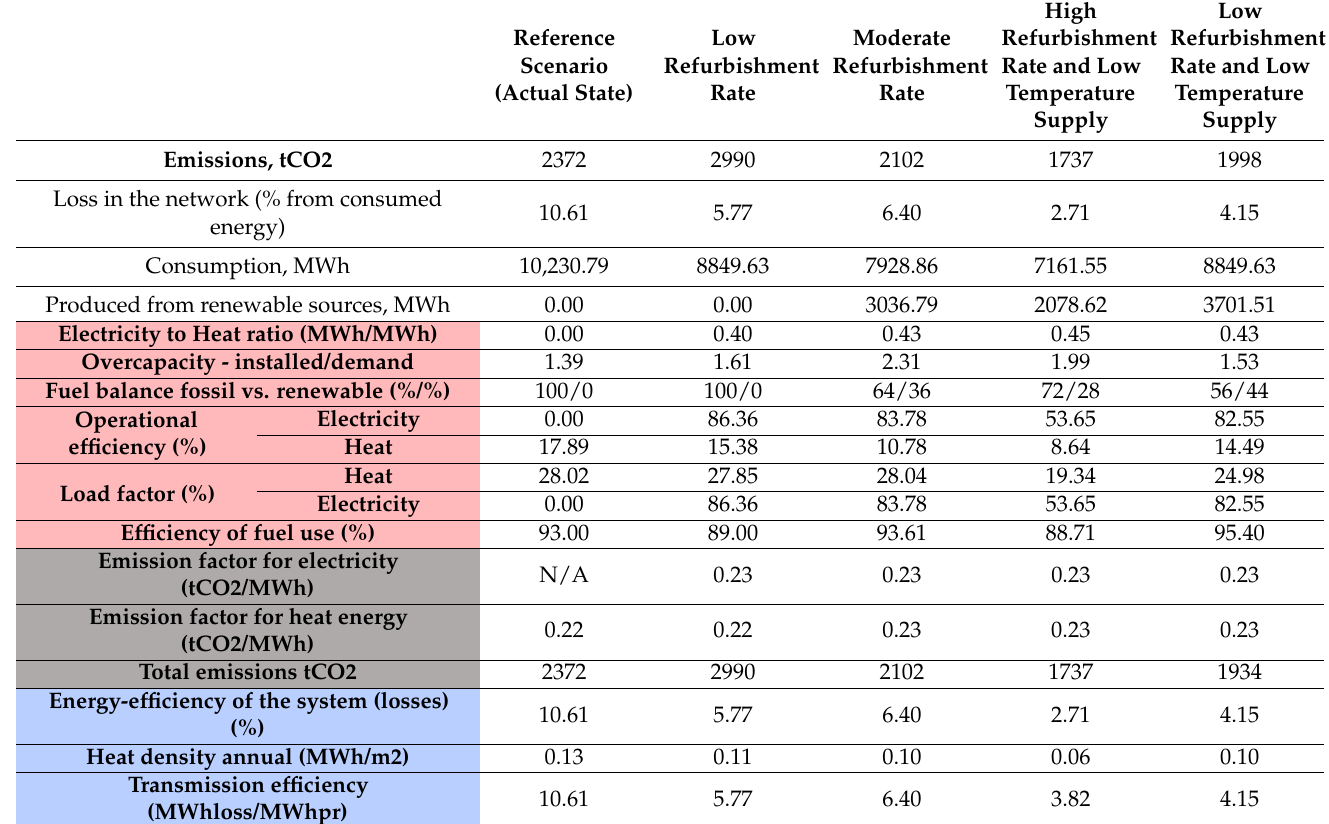
Table 3. Summary of results for simulation of all